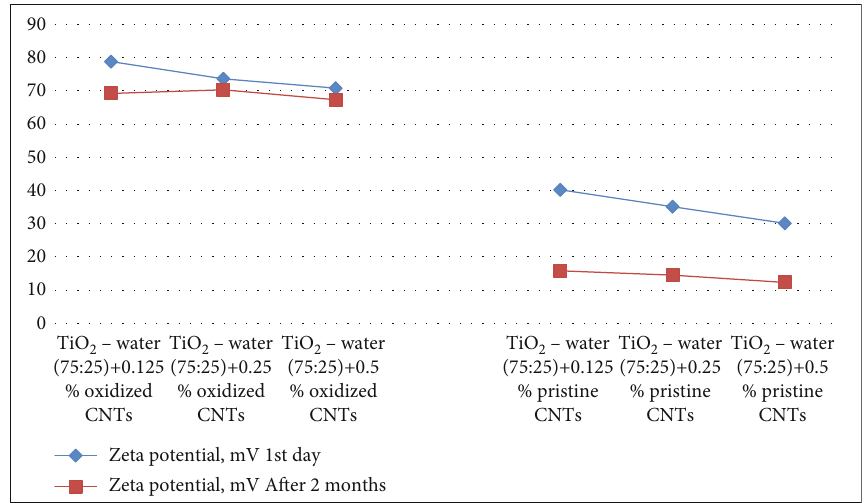
Figure 11: Zeta potential changes of nano fl uids including pristine and oxidized CNTs during 60 days for a TiO